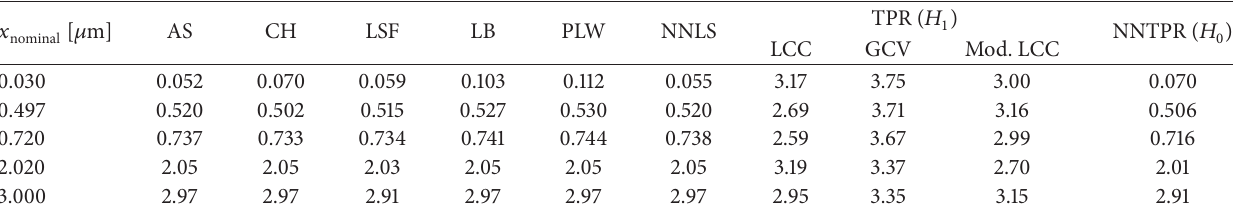
Table 3: Comparison of the retrieved Sauter mean particle size 𝑥 3,2 and 𝑙 = 1000 .